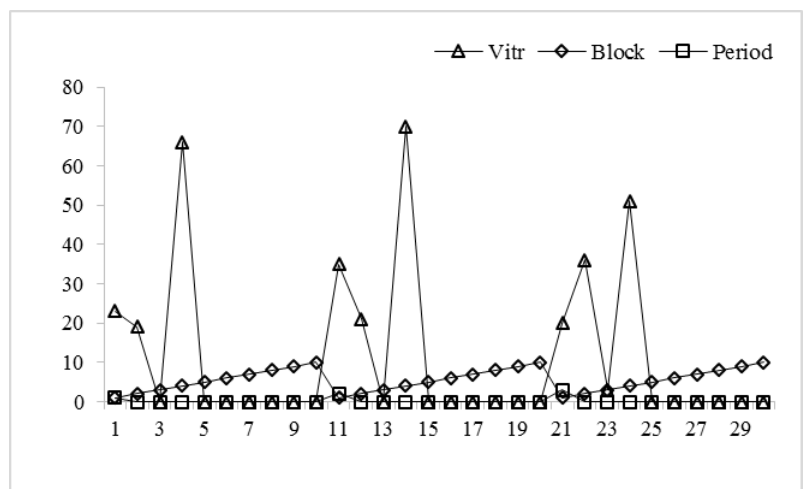
Figure 4: The evolution of variables of containers C1 and C2 for 10 blocks